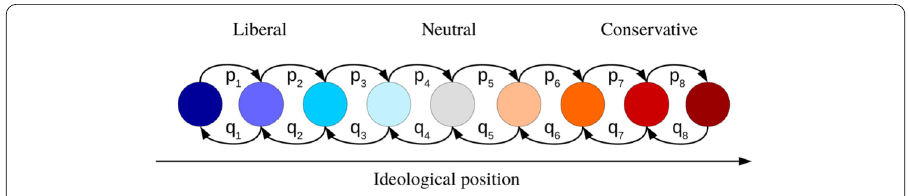
Figure 2 Polarization model. In our model, the political spectrum consists of N different states and is divided in three groups: liberal, neutral, and conservative. For illustrative purposes, we set N = 9 in this example. The transition probabilities are denoted by { p i } i ∈{ 1, ... ,9 } and { q i } i ∈{ 1, ... ,9